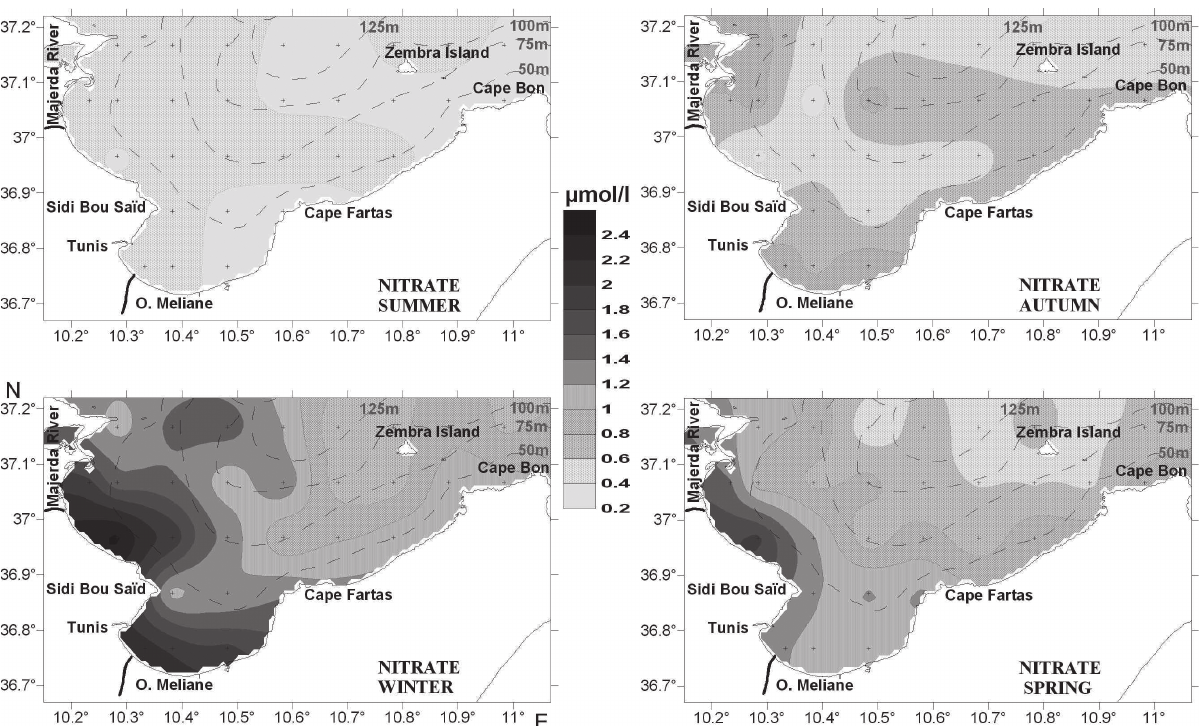
Fig. 4. – nitrate (no 3- ) distribution by season.